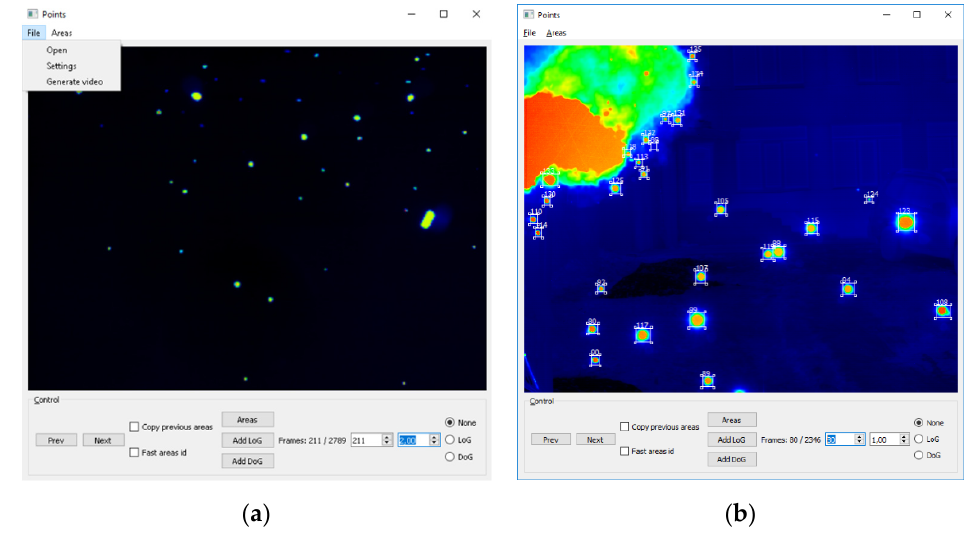
Figure 4. Developed software: ( a ) graphical user interface, ( b ) video